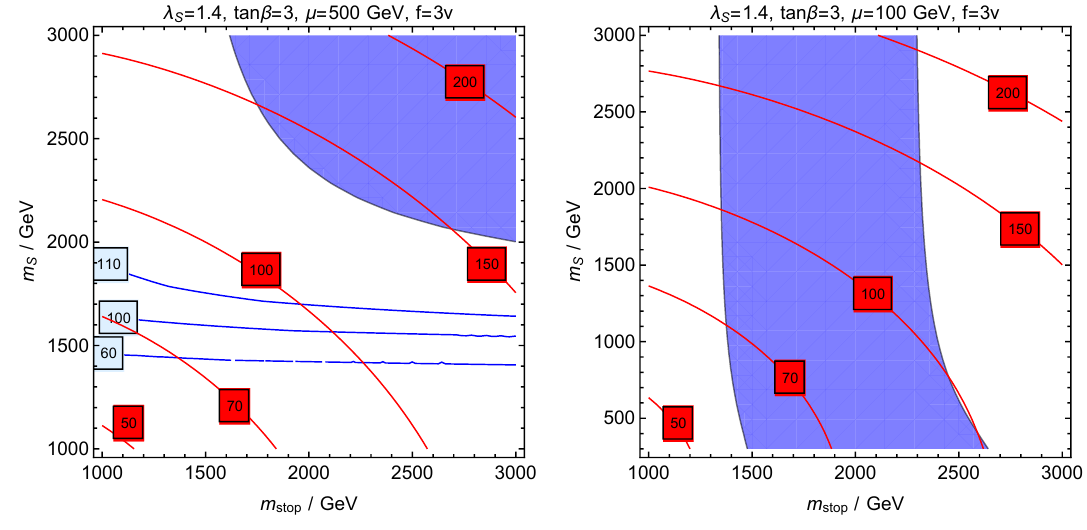
Figure 3 . The SM-like Higgs mass of m h = 125 (cid:6) 3 GeV (blue region) in the plane m stop - m S for (cid:21) S = 1 : 4, f = 3 v , tan (cid:12) = 3, m A = 1 : 5 TeV, M 3 = 2 TeV and (cid:22) 0 = 0 in the F -term Twin Higgs model. In the left (right) panel (cid:22) = 500 (100) GeV. The red contours correspond to total (cid:12)ne-tuning of the model. The blue contours in the left panel depict values of m h